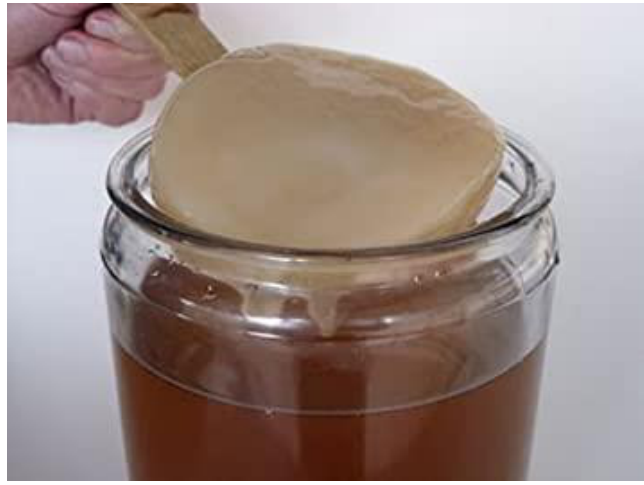
Figure 8. Kombucha starter, the